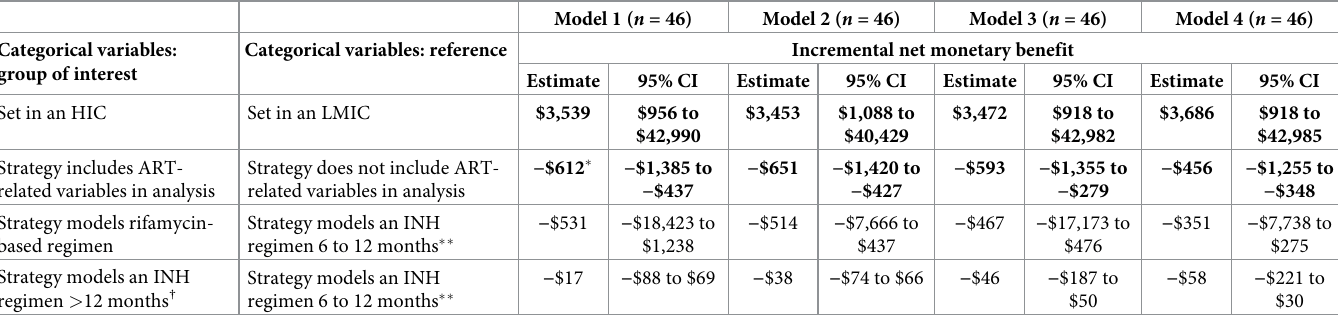
Table 5. Multivariable quantile regression models: incremental net monetary benefit comparing TPT to no TPT (2020 USD).